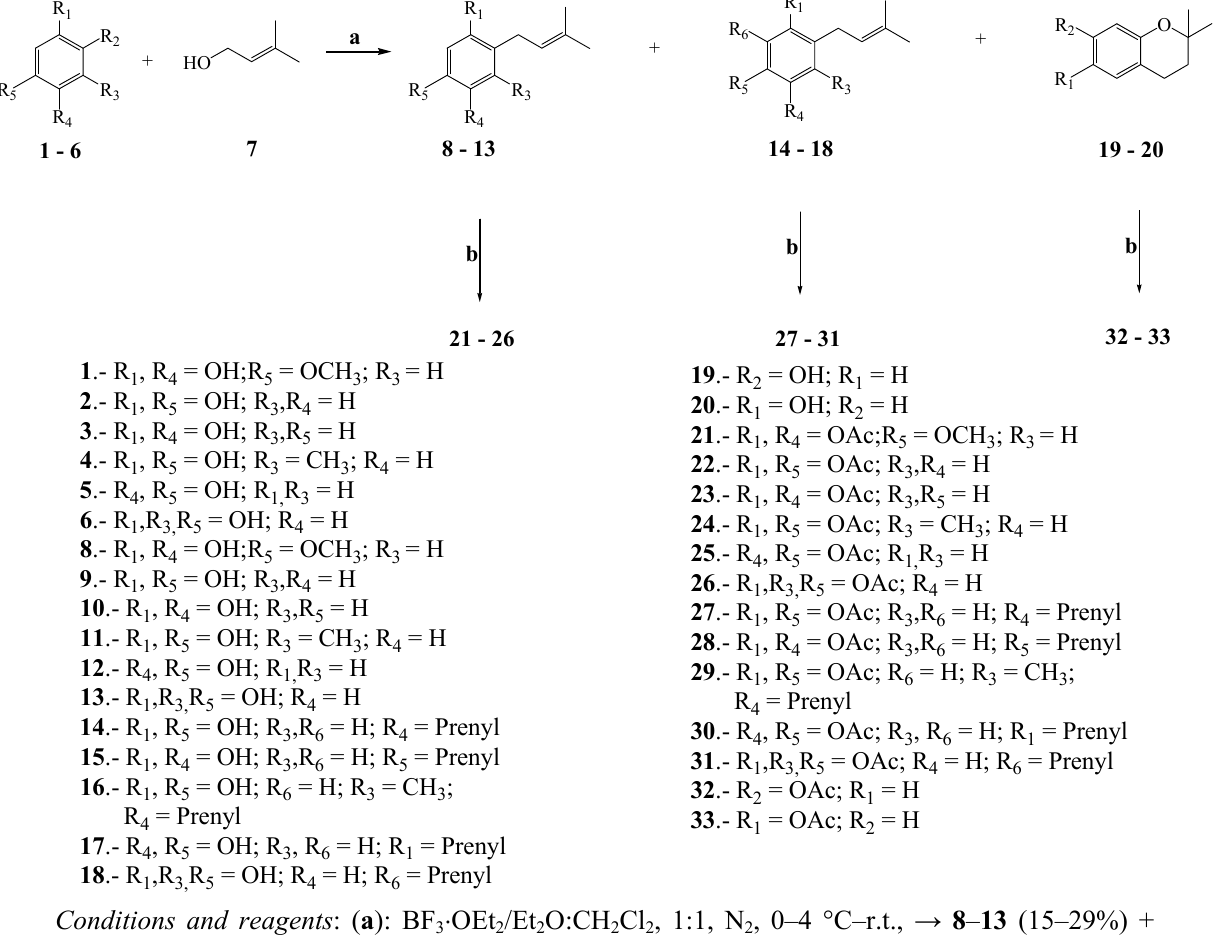
Scheme 1. Synthesis of prenylated phenols and their acetylated derivatives in two